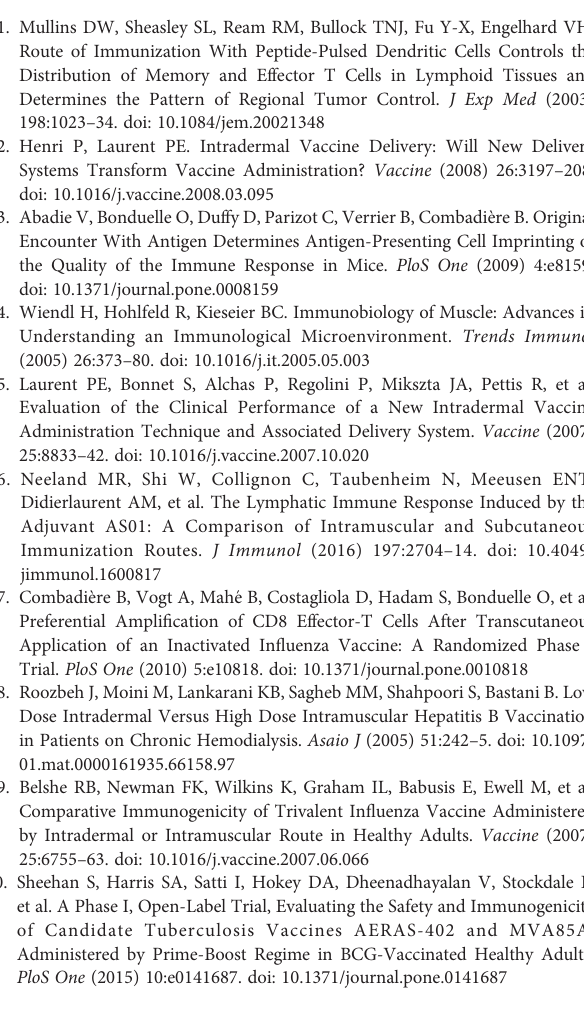
Supplementary Figure 1 | Analysis pipeline of the CyTOF dataset. Supplementary Figure 2 | Overview of the kinetics of differentially enriched clusters.